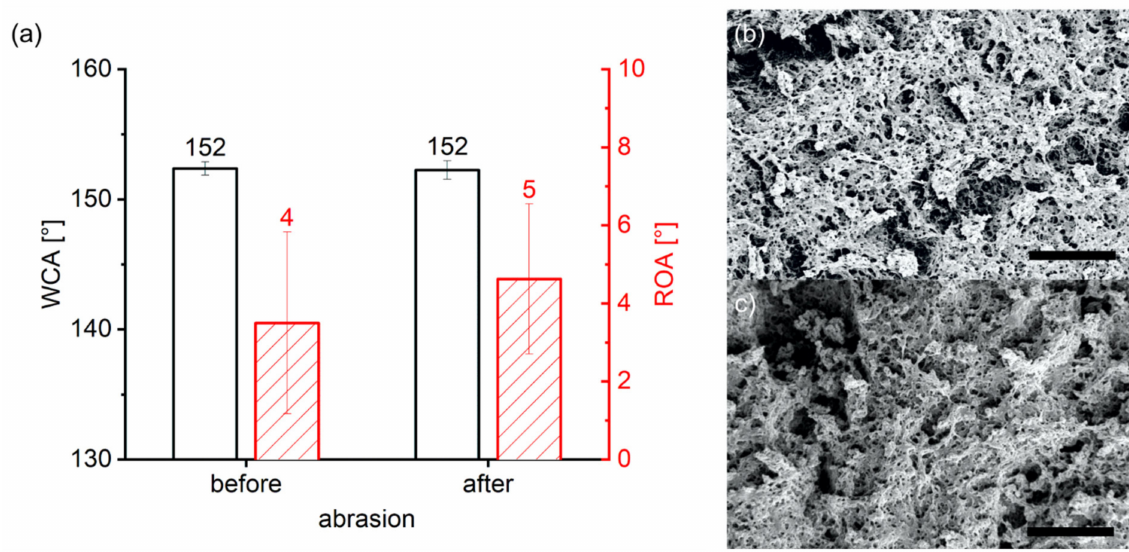
Figure A3. Robustness of Fluoropor films showing stable repellence and surface structure: ( a ) The WCA and ROA were measured with 5 µ L water droplets on the Fluoropor surface before and after abrasion, showing that no significant change of the repellence upon abrasion. ( b ) Micro-graphical image of Fluoropor15 before and ( c ) after 100 abrasive cycles showing no significant change. Scale bar: 5 µ